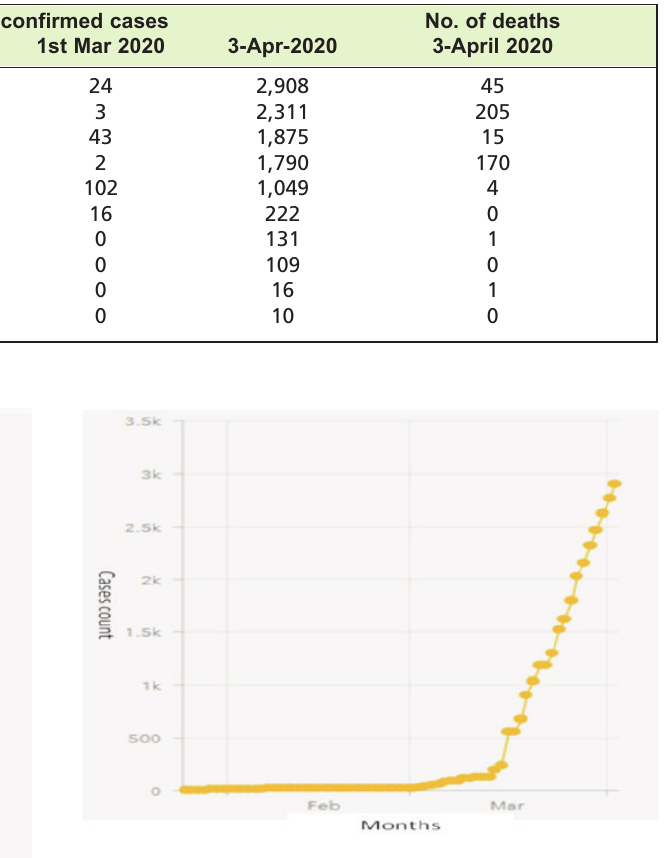
No of COVID-19 cases in Singapore by date 10 . Fig. 1: